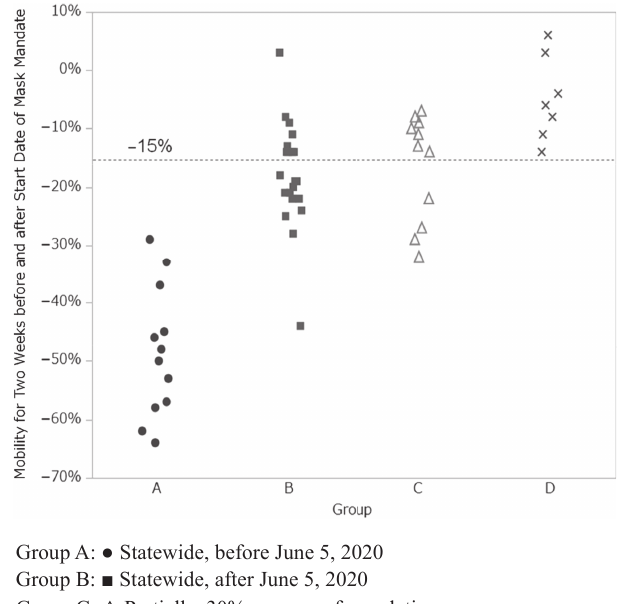
Figure 5. Average mobility for four weeks (two weeks before and after the start date of mask mandates) for the 50 U.S. states and Washington,